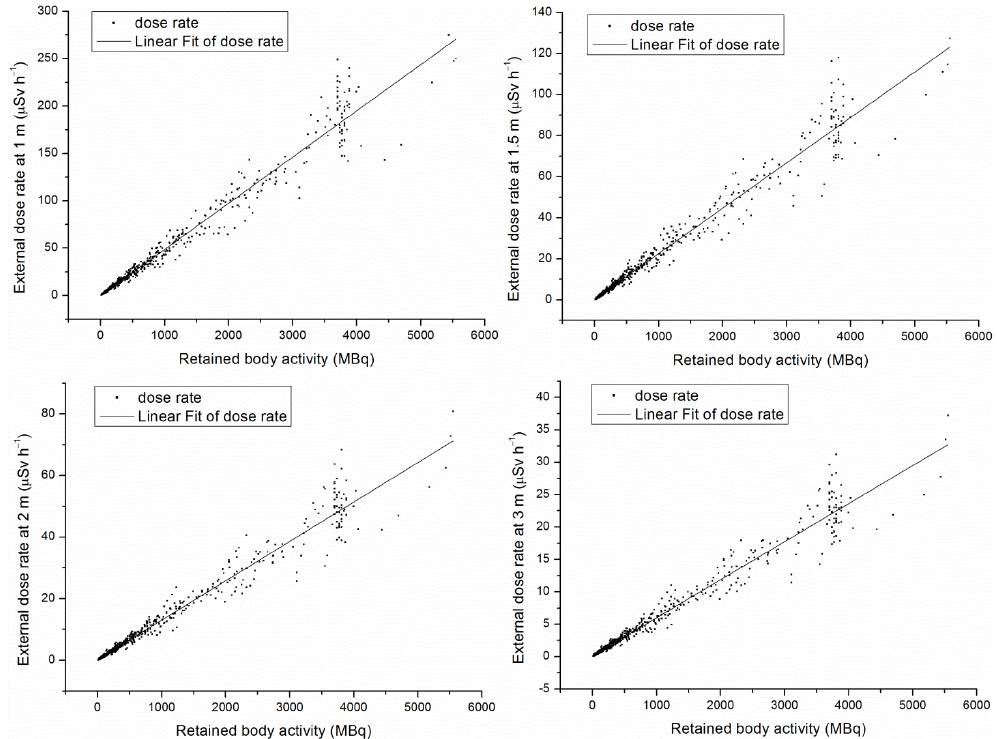
Figure 4. Retained body activity corresponding external dose